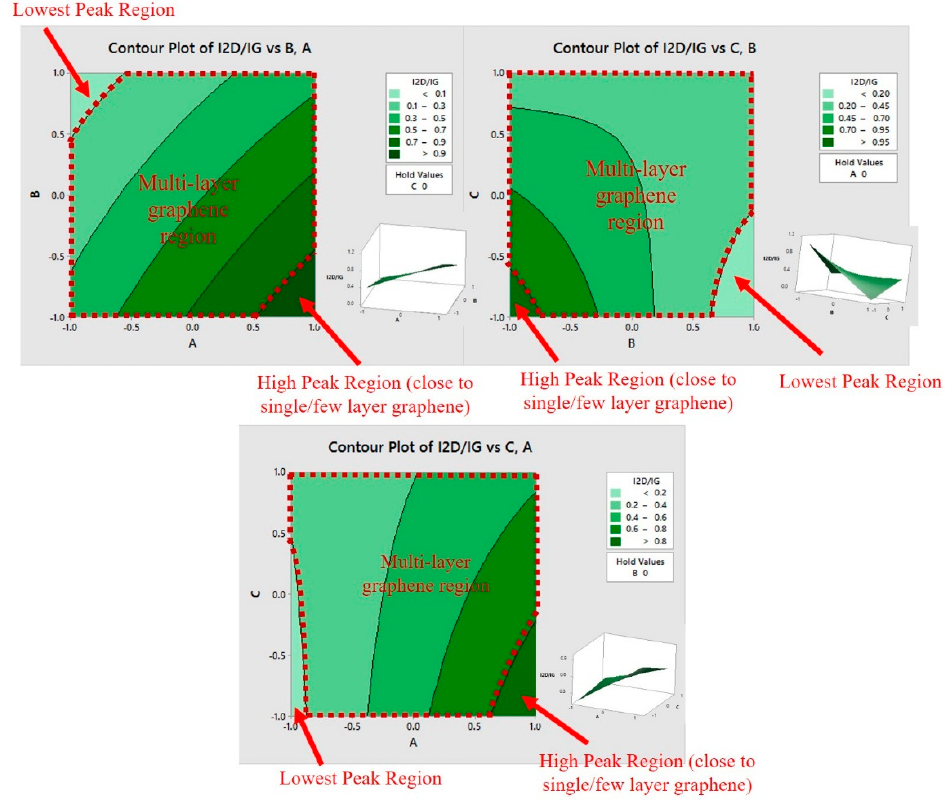
Figure 8. Contour plots for Response II with respect to the factors “A”, “B” and “C”; the insets show the surface plots. The area within dotted boundaries represents multi ‐ layer graphene.